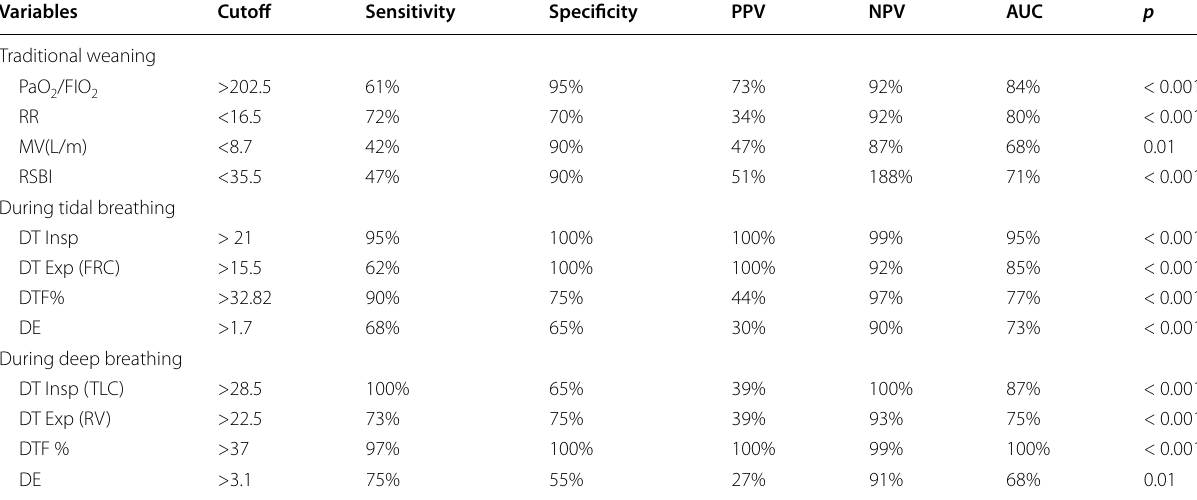
Table 2 Diagnostic accuracy of a new weaning index (diaphragmatic index) with tidal breathing, during deep breathing and traditional